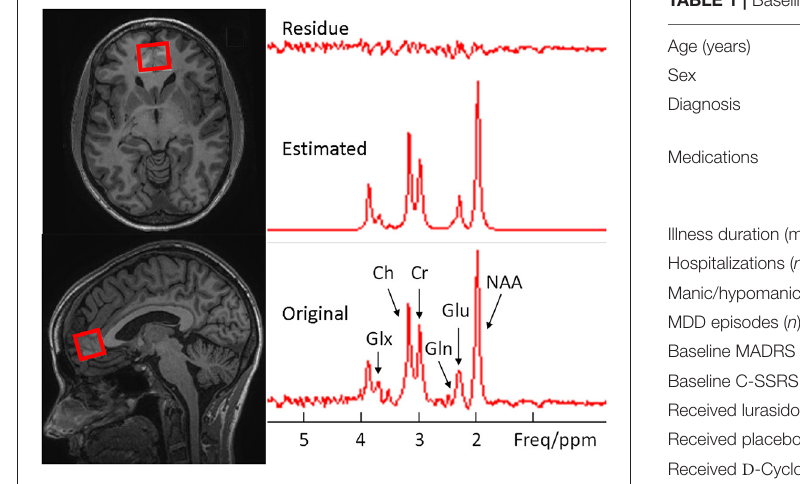
FIGURE 2 | Examples of voxel placement (red outline) on the axial and sagittal localizer images showing the size and location in the medial ventral prefrontal cortex (Left) and the original, estimated, and their difference spectra from the voxel (Right).